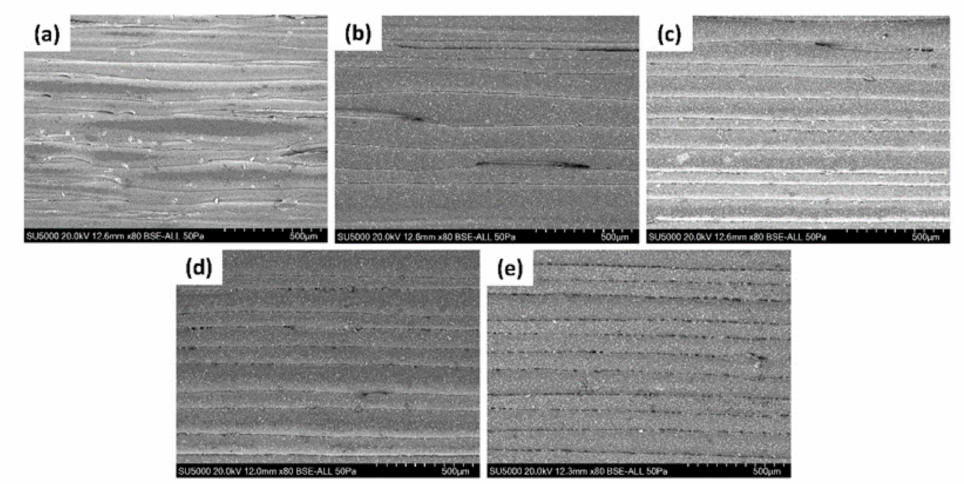
Figure A2. Cross-sectional BSE SEM images of 3D printed ( a ) pure PEEK, ( b ) 5 wt% PEEK/HA, ( c ) 10 wt% PEEK/HA,